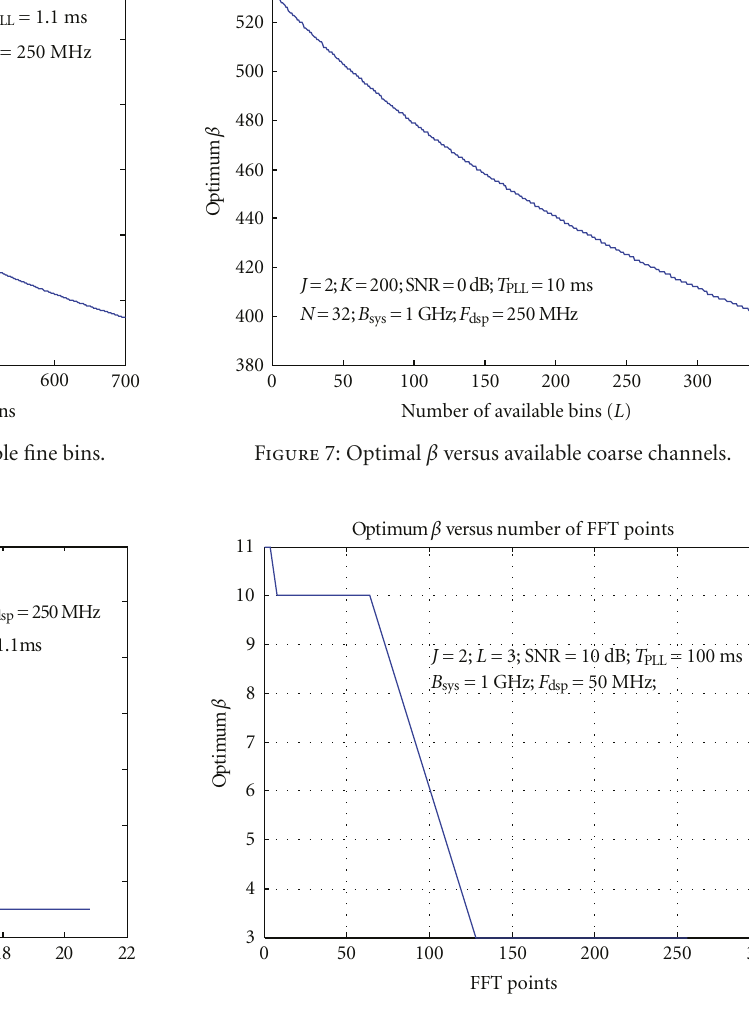
Figure 8: Optimal β versus number of FFT